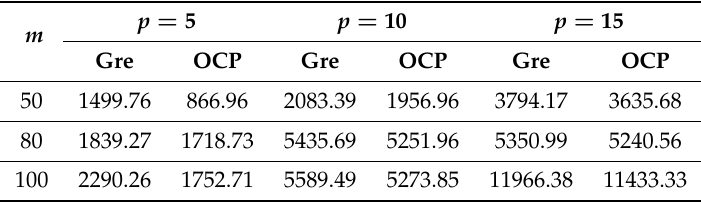
Table 5. Runtimes of Two Methods (s).